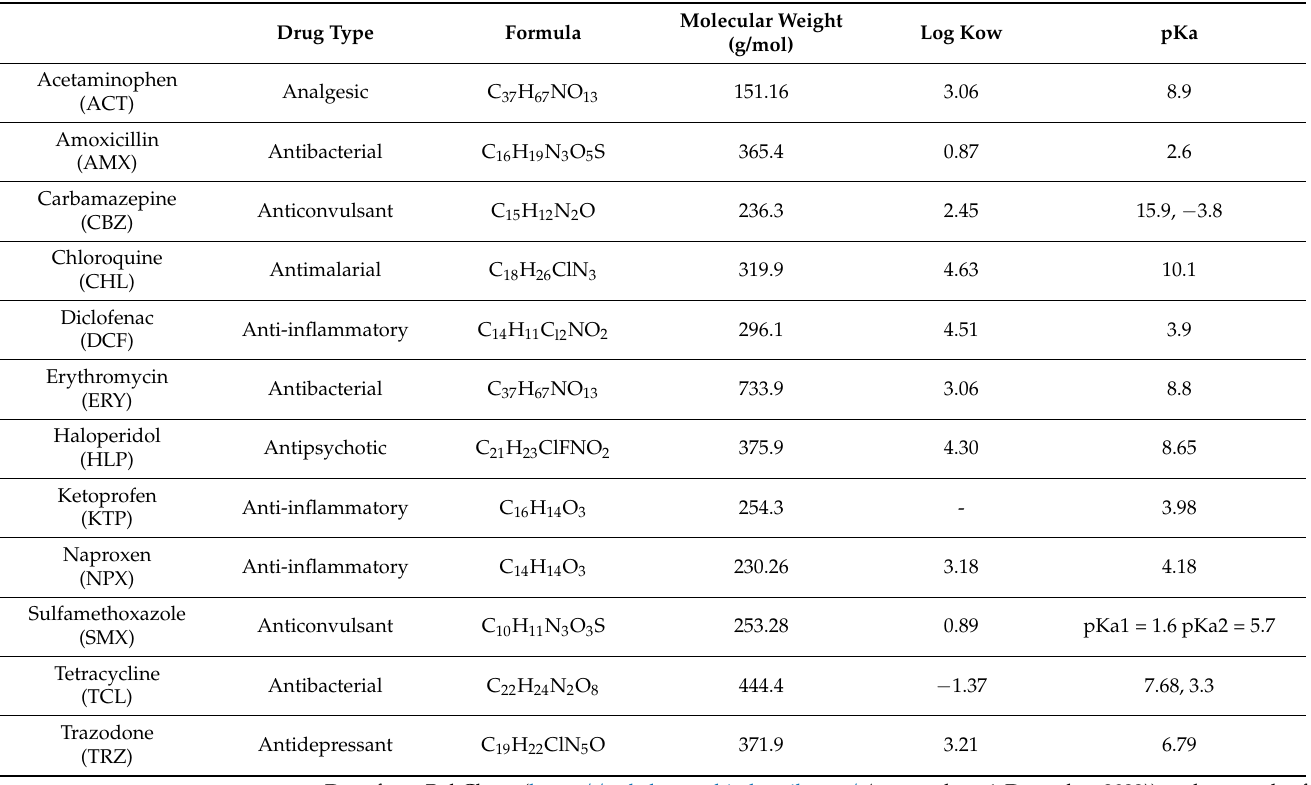
Table 1. Physico-chemical properties of selected